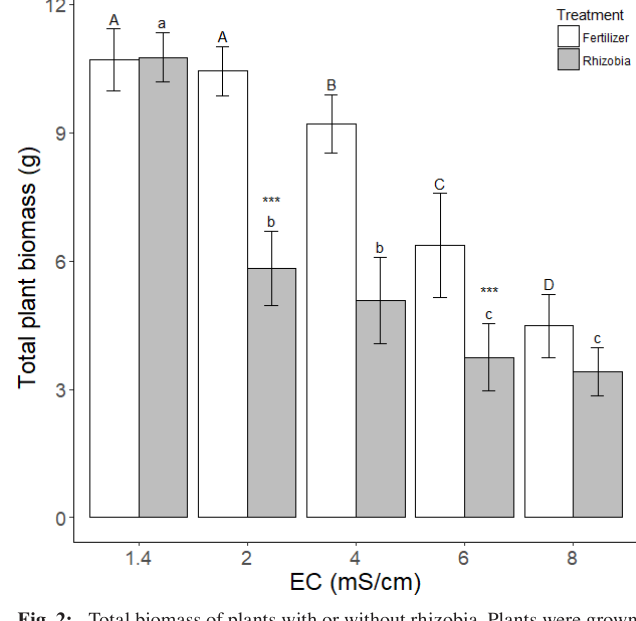
Fig. 2: Total biomass of plants with or without rhizobia. Plants were grown in soils with different electrical conductivity (EC) and total plant biomass (dry weight) was determined after 8 weeks of cultivation. Bars are means (±SD), lower (rhizobia) and upper case letters (ferti- lizer, no rhizobia) show significant differences among experimental plants according to post-hoc analysis (Tukey’s HSD, p<0.01) after one-way ANOVA.